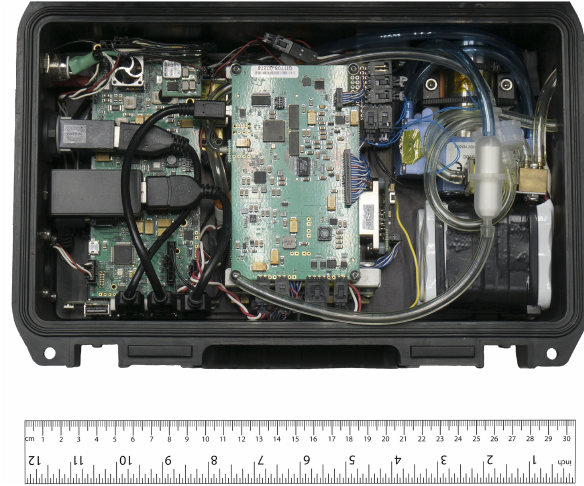
Figure 1. Internal view of the mid-IR, absorption-based HCHO sen- sor from Aeris Technologies. The sensor fits inside a Pelican case that provides for easy transport and